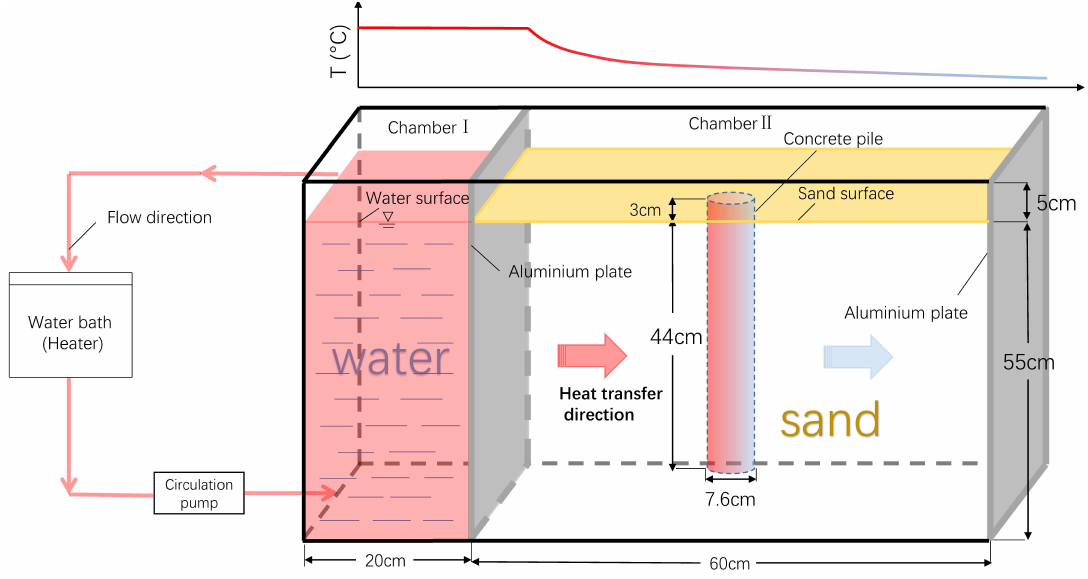
Figure 1. Schematic diagram of the test equipment.